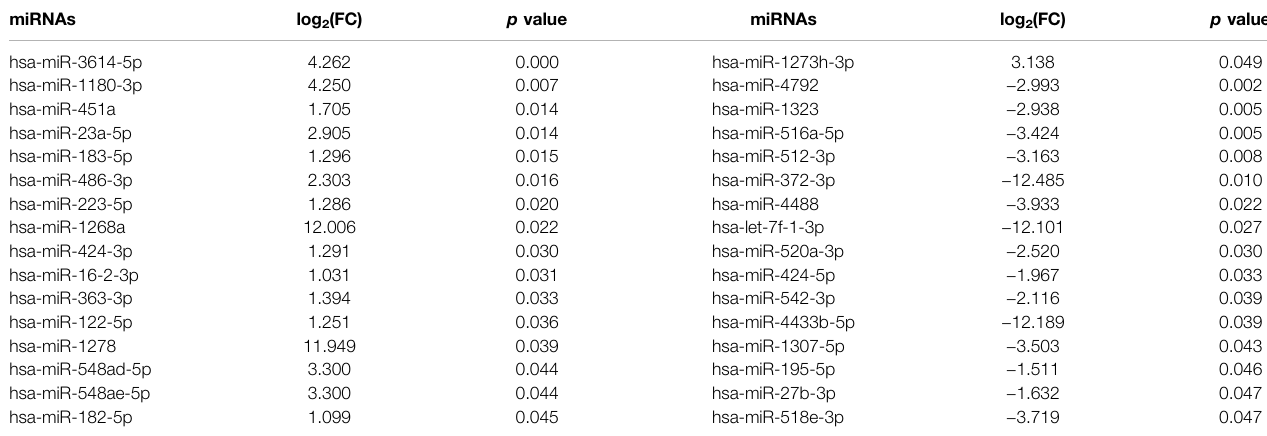
TABLE 2 | DE miRNAs in the neutrophil exosomes of DM patients ( n (cid:2) 32). miRNAs